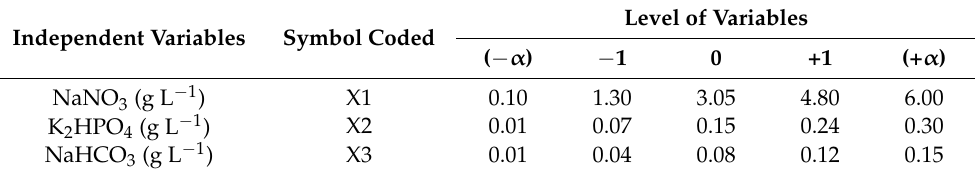
Table 1. Differential experimental range and level of independent variables.